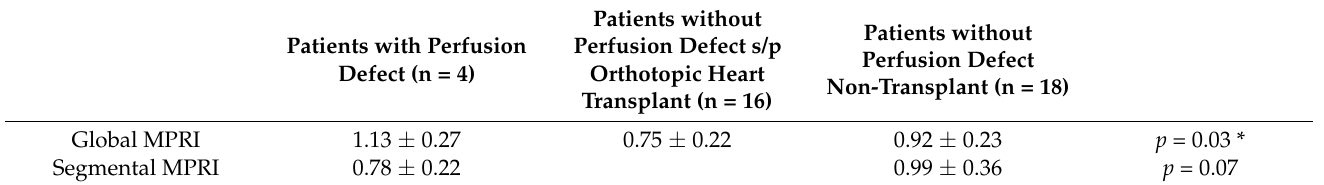
Table 3. Comparison of global and segmental MPRI in patients with and without perfusion